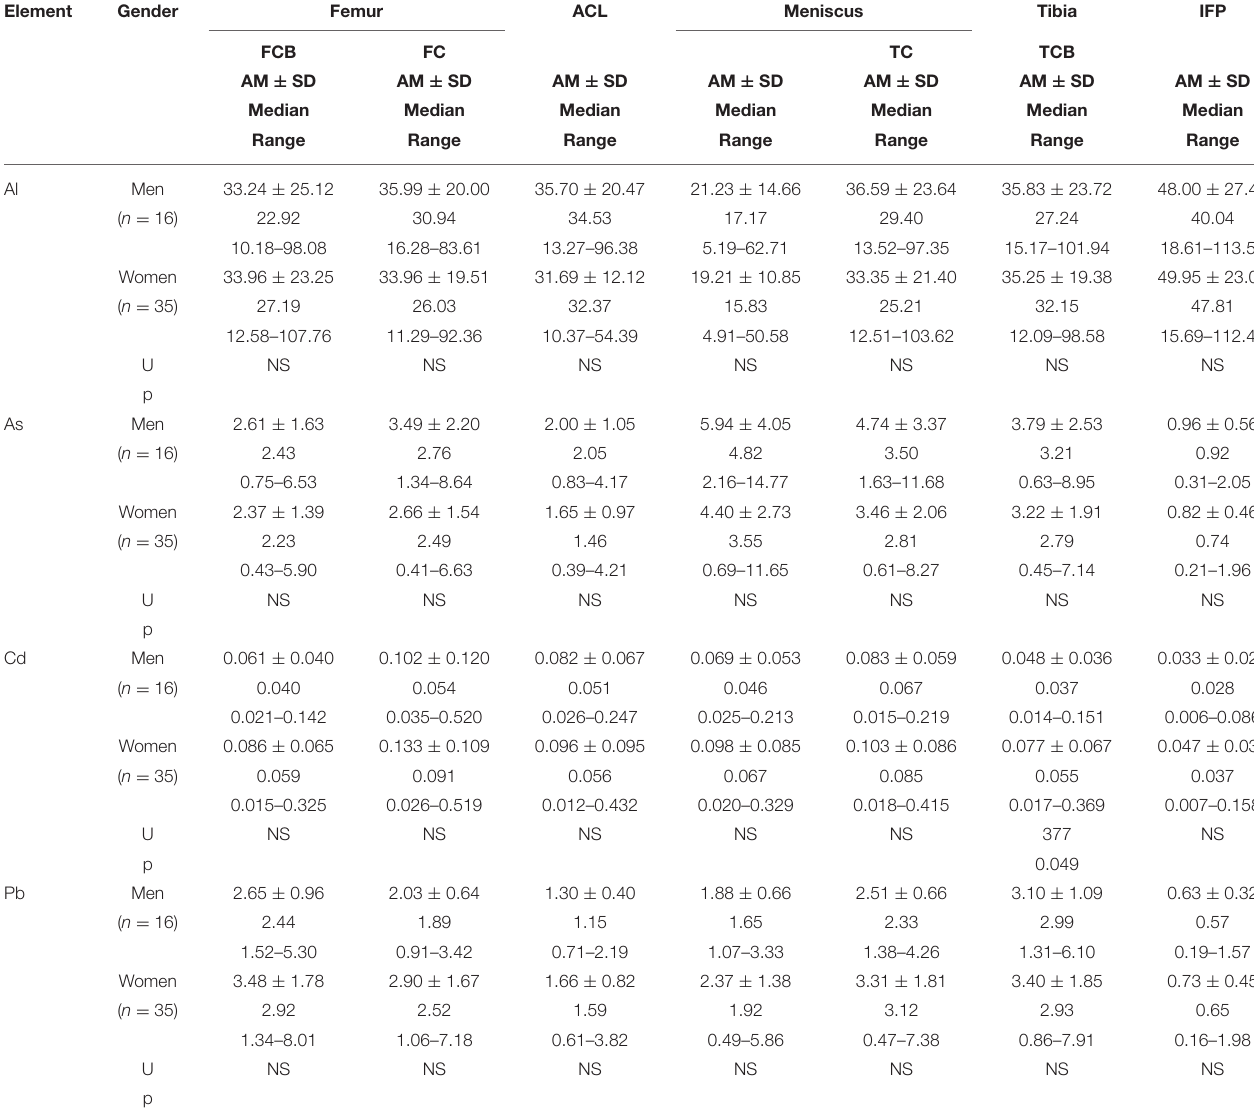
TABLE 4 | Analysis of the Al, As, Cd, and Pb concentrations in the structures of knee joint in men and in women. Element